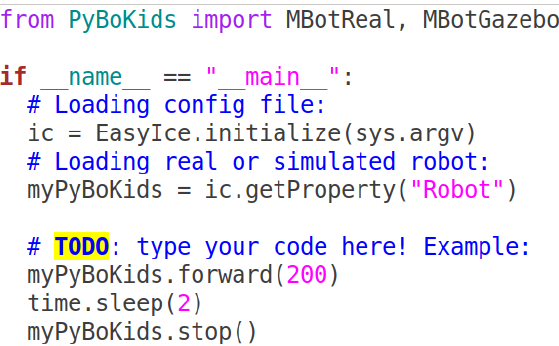
Figure 4. PyBoKids Python code example